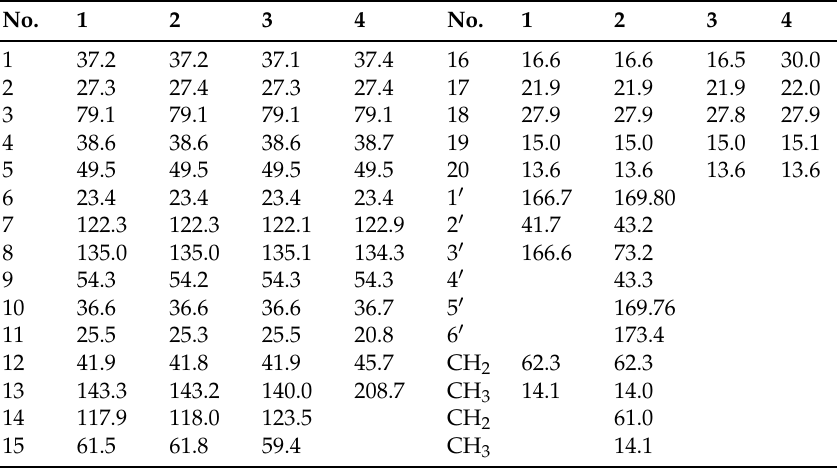
Table 2. 13 C-NMR data (125 MHz, δ in ppm) of compounds 1 – 4 in CDCl 3